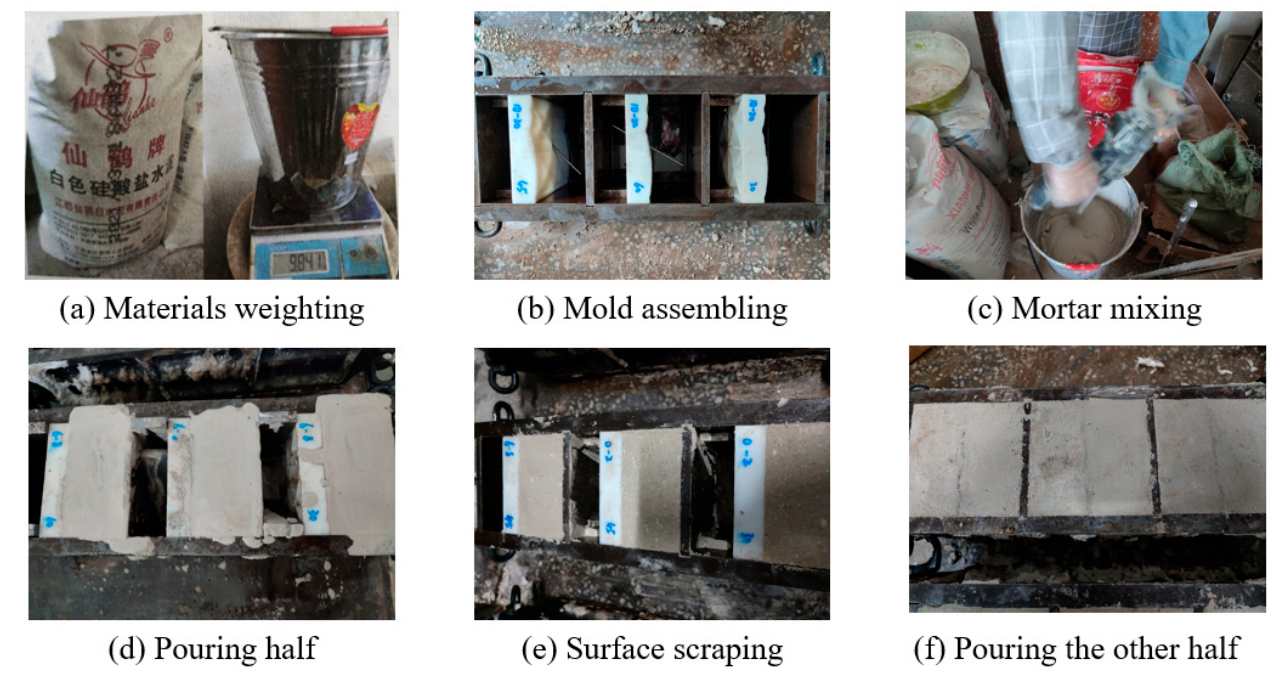
Figure 3. Fabrication of specimens with different JRC.